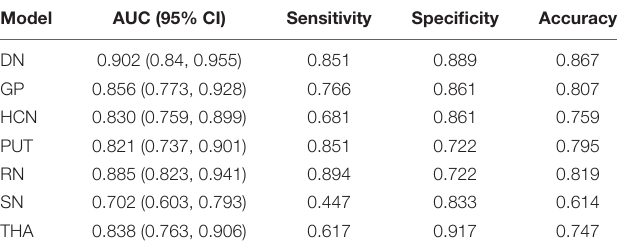
TABLE 4 | Comparison of the different radiomics models.